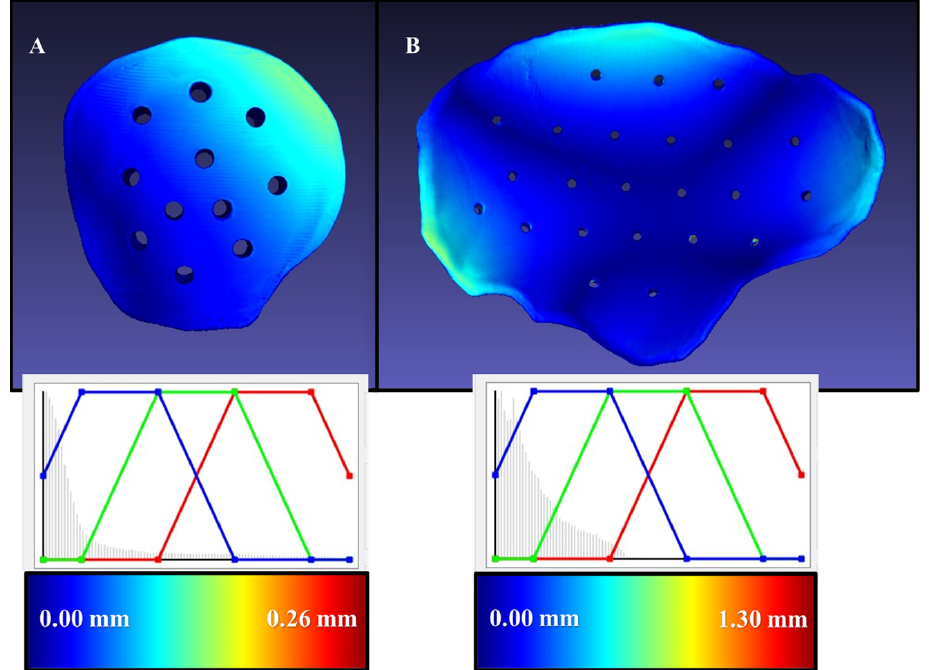
Figure 5 . Heatmaps depicting the Hausdor ff distances for two exemplary 3D printed PEEK custom- ized cranial implants. The minimal and maximal values are color-coded and displayed in millime- ters (mm). ( A ) Small-sized cranial implant model; ( B ) large-sized cranial implant model.